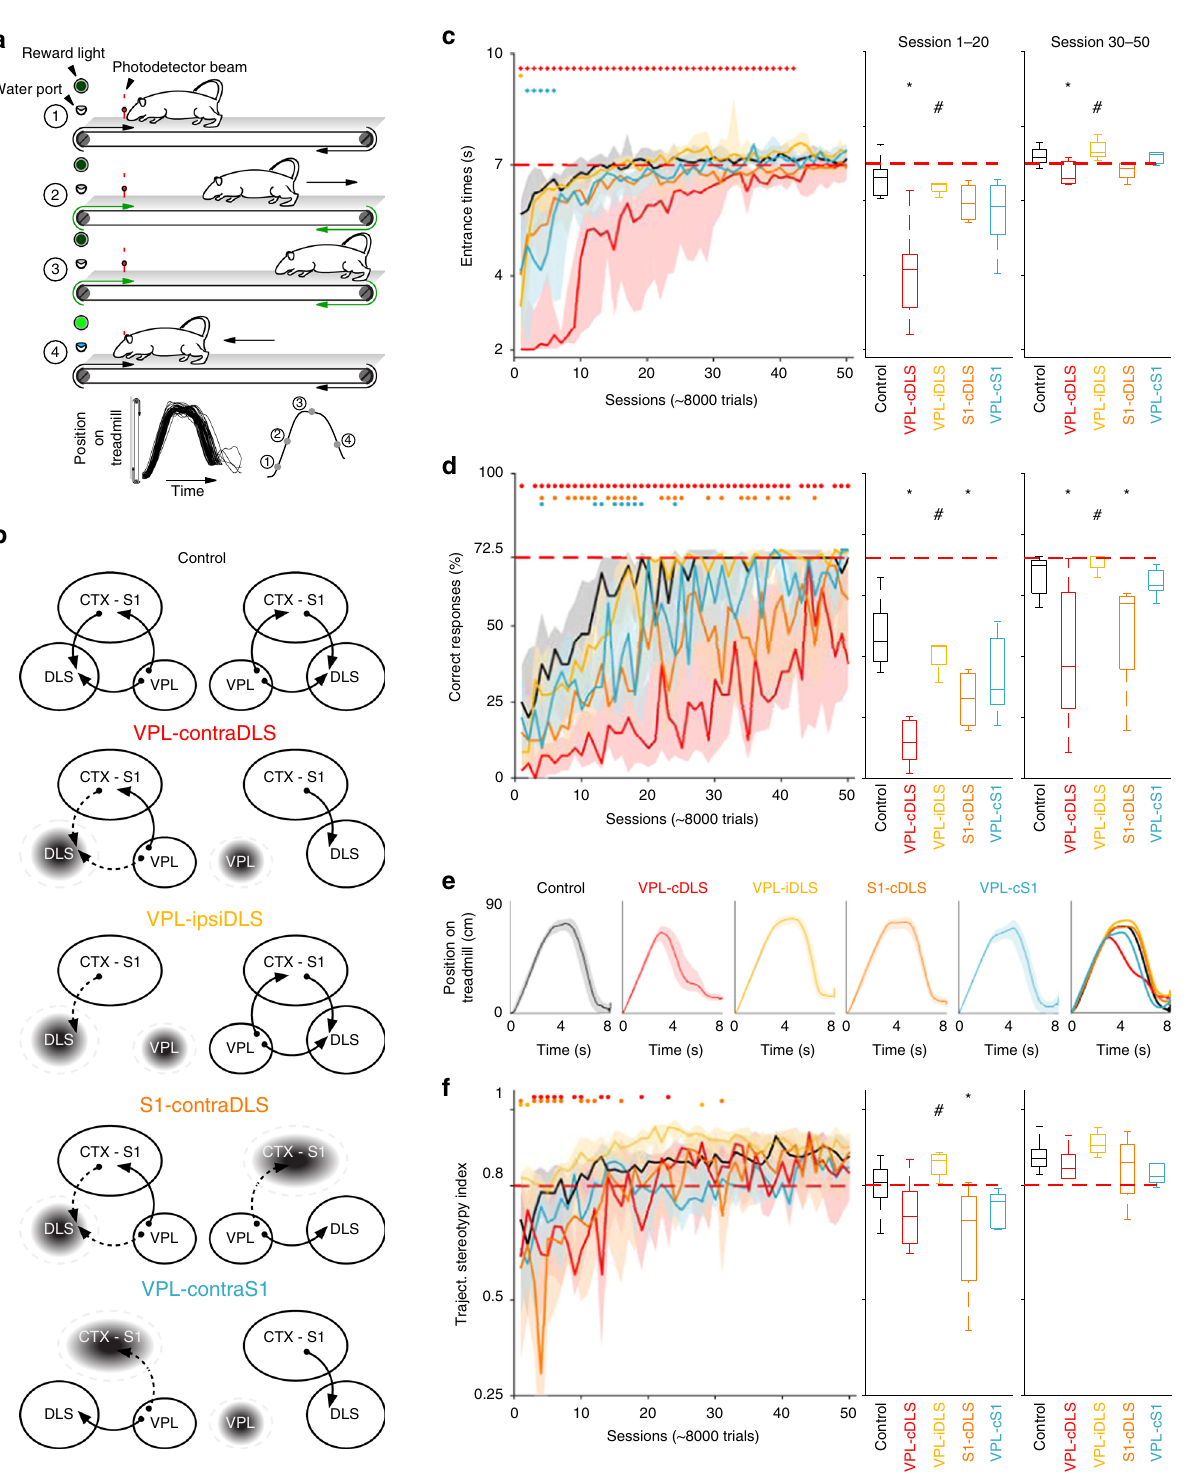
Fig. 4 Effects of disrupting sensory fl ow of information to the DLS. a Schematic representation of the different phases of the Fron – Back – Front strategy expressed by the animals in the spatiotemporal task. Trajectories for every trial and average trajectory of a representative session are presented at the bottom. The different phases of the sequence are indicated in the average trajectory. b Schematic view of functional disconnections to remove forelimb somesthetic information from the DLS. Lesions are represented as dark areas in the corresponding structures. c , d , f Goal area entrance times ( c ), percentage of correct trials ( b ), and position stereotypy index ( f ) for the different experimental groups. Data are presented as median + 75th and 25th percentiles for the entire learning curve (left) or grouping early (middle) or late (right) sessions of training. Horizontal lines (left; two-way ANOVA, group × day of training and Bonferroni post hoc test); * and # represent signi fi cant differences vs. control and VPL – DLS groups, respectively (one-way ANOVA and Bonferroni post hoc test). e Representative position trajectories for one animal from each experimental group (median + 75th and 25th percentiles; color code as in ( b